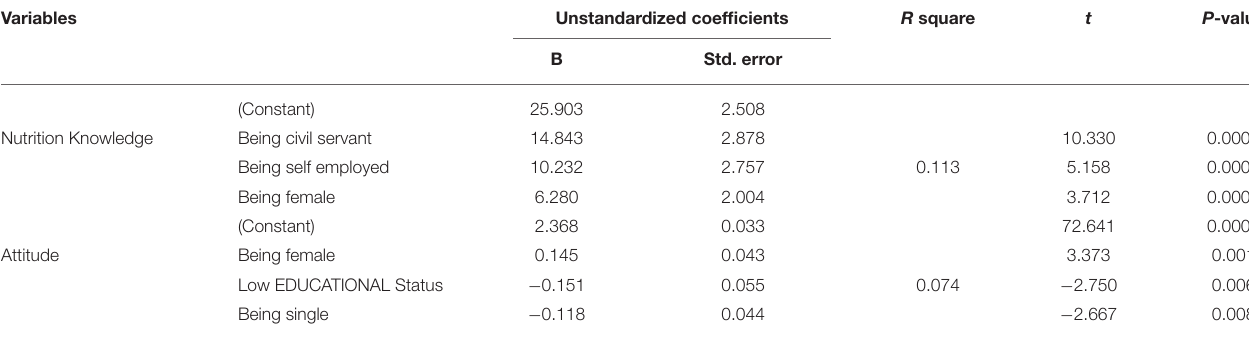
TABLE 5 | Influence of socioeconomic characteristics on the nutrition knowledge and attitude of people living with HIV/AIDS.